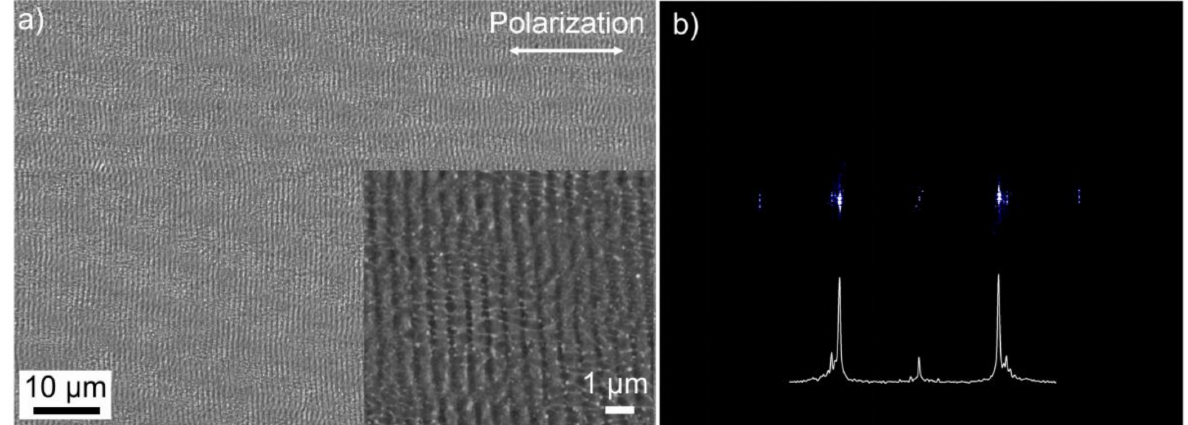
Figure 6. LIPSS structuring of stainless-steel surfaces using the squared top-hat profile (z = 0 mm) of the linearly polarized fs-laser beam (2w f ~30 µ m, E imp = 3.5 µ J, v = 1 m/s, ∆ x = 10 µ m): ( a ) SEM micrograph and ( b ) 2D-FT spectrum and its corresponding cross-section calculated from the SEM micrograph quantifying the homogeneity and orientation of the